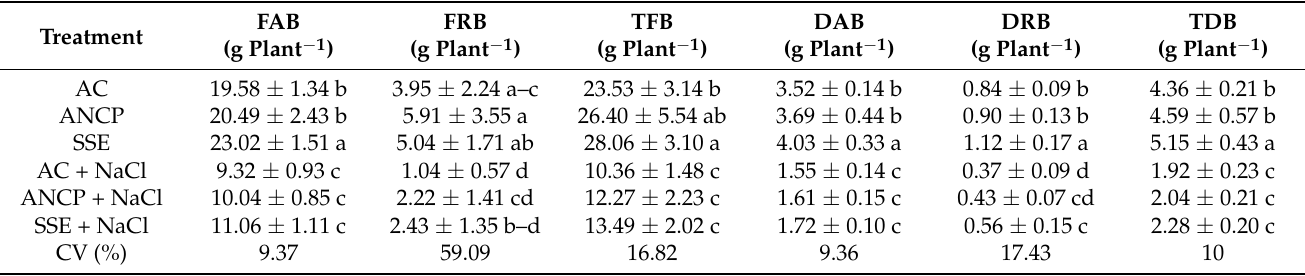
Table 2. Fresh and dry biomasses of tomato seedlings at the end of the experiment.